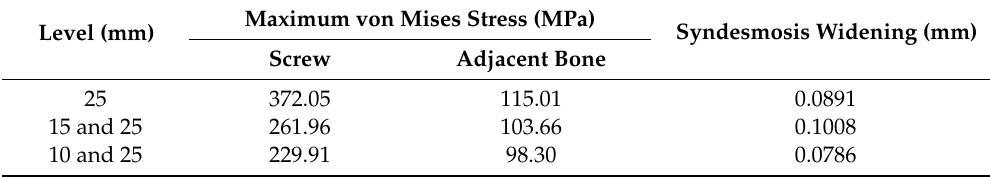
Table9. MaximumvonMisesstressesandsyndesmosiswidening: doubletitaniumscrewof4.5diameter Table 9. Maximum von Mises stresses and syndesmosis widening: double titanium screw of 4.5 with four cortical diameter with four cortical bones.